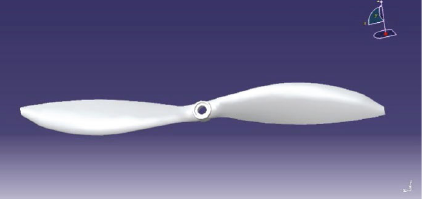
Figure 8: Design-1.